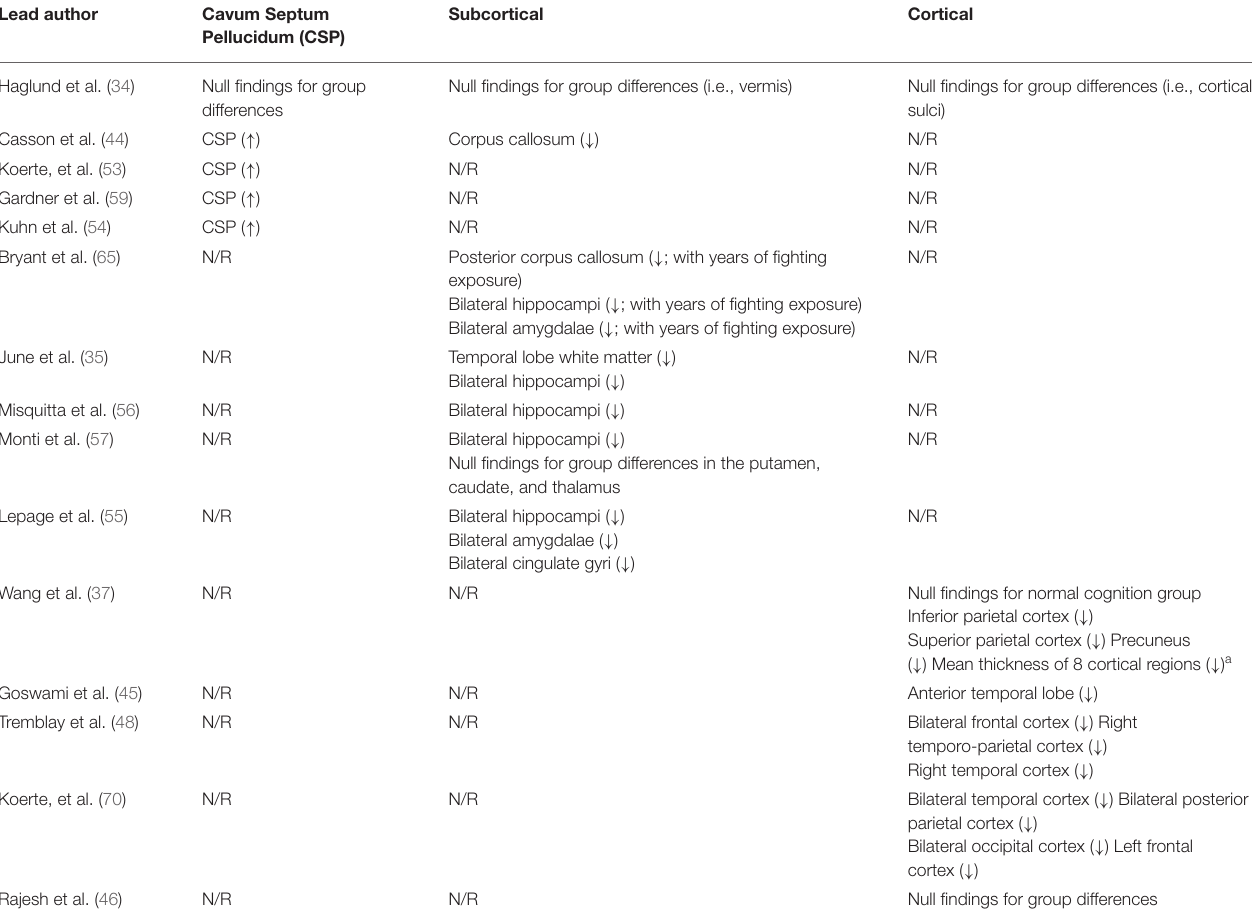
TABLE 2 | Aggregated results for all structural imaging studies. Lead author Cortical